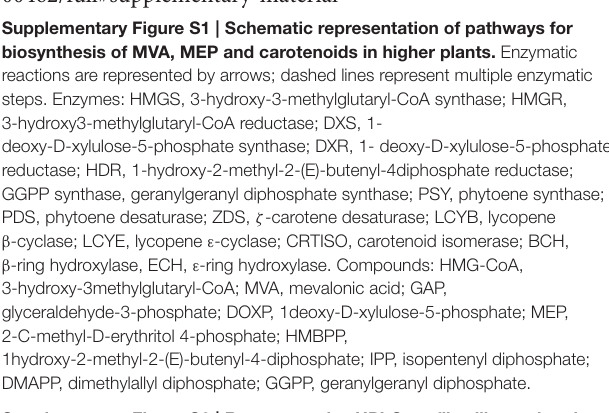
Supplementary Figure S2 | Representative HPLC profiles illustrating the accumulation of carotenoids in fruit-pulp of banana. Peaks in chromatograms are representing 1: lutein, 2: zeaxanthin, 3: α -carotene, 4: β -carotene and 5: lycopene. Extract was separated with HPLC coupled with UV and PDA